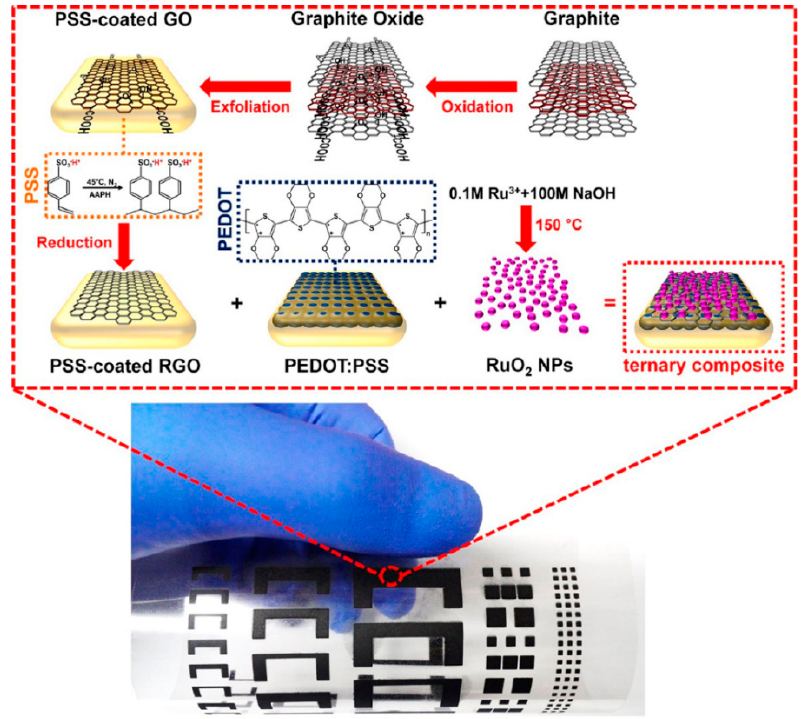
Figure 16. The whole process of screen printing the RuO 2 composite electrode, and the sample of screen printed electrode of the supercapacitor. Reproduced from [96], with permission from American Chemical Society, 2015.